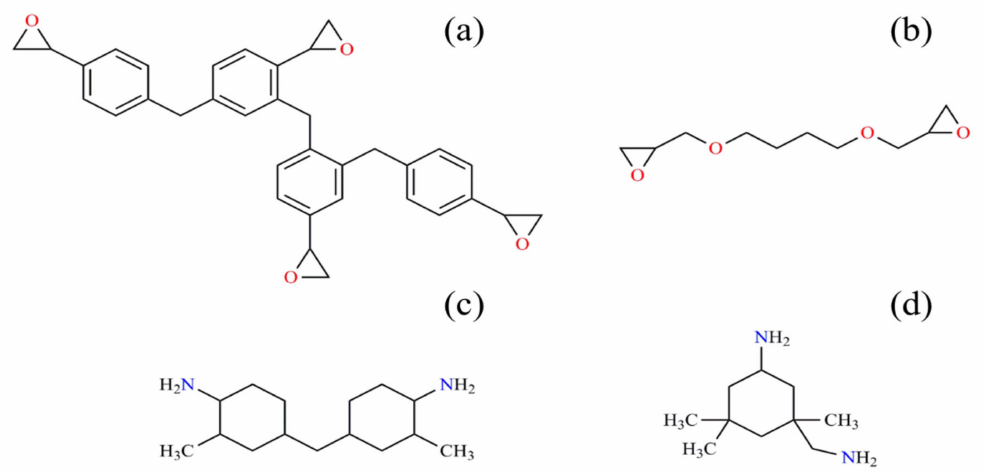
Figure 9. Chemical structures of Araldite LY 5052 epoxy resin components: ( a ) epoxy phenol novolac, ( b ) butanediol digylicidyl ether and Aradur HY 5052 hardener components, ( c ) cycloaliphatic diamine, and ( d )